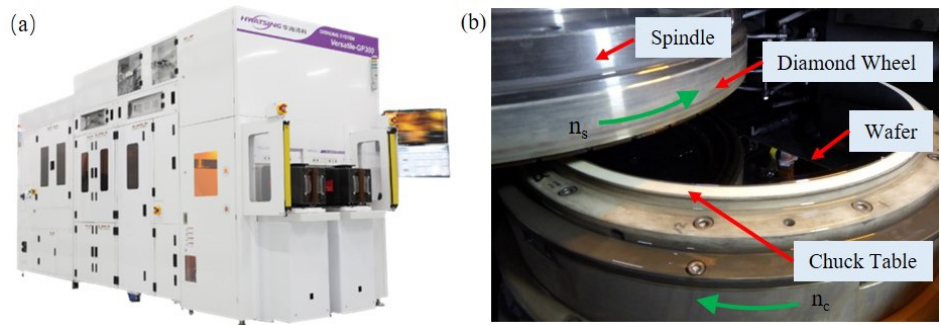
Figure 12. Diagram of the experiment setup. ( a ) The ultra-precision grinding machine tool: Versatile- GP300 [35]. ( b ) The internal structure when a wafer is mounted on the chuck